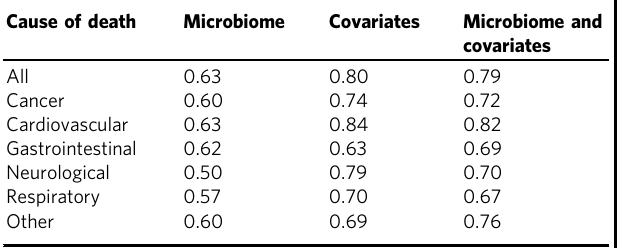
SurvivalRandomForestwastrainedwiththeEasternpopulationandthentestedontheWestern population. A c -statistic of 0.5 corresponds to a random expectation, and higher values indicate improvedperformance.Incorporatingcoremicrobiomefeaturesdidnotsigni fi cantlyimprovethe c -statistic over the host